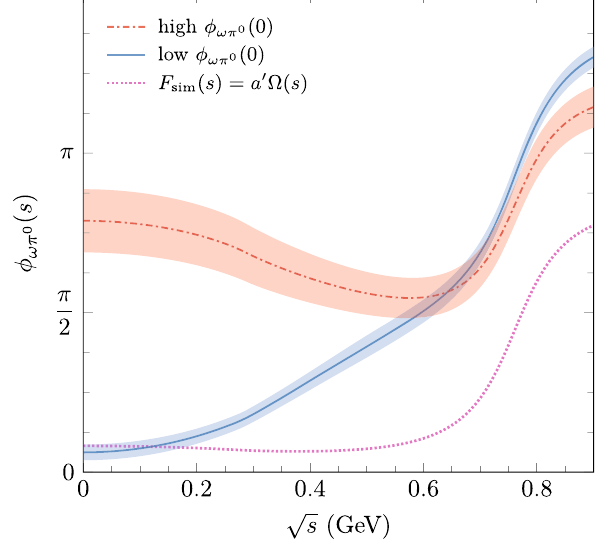
Fig. 8 Dependence on s of the phase of the ωπ 0 transition form factor, φ ( s ) , for the two different solutions described in the text. At s = 0, ωπ 0 the phase is given by the fitted parameter φ ωπ 0 ( 0 ) shown in Table 2. The error bands represent our (correlated) 1 σ uncertainties in the fitted parameters, obtained from a MC analysis of the data. We show here the curves for the “3 par.” fit. The phases for the “2 par.” case are very similar. For comparison, we also show the prediction of the model without KT equations (dotted pink curve) discussed in Sect. 3.3, cf. Eqs.